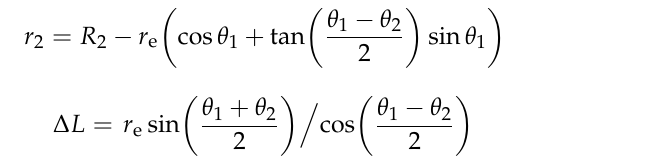
Figure 6. Definition of the distance from point 𝑃 to the guiding cone.